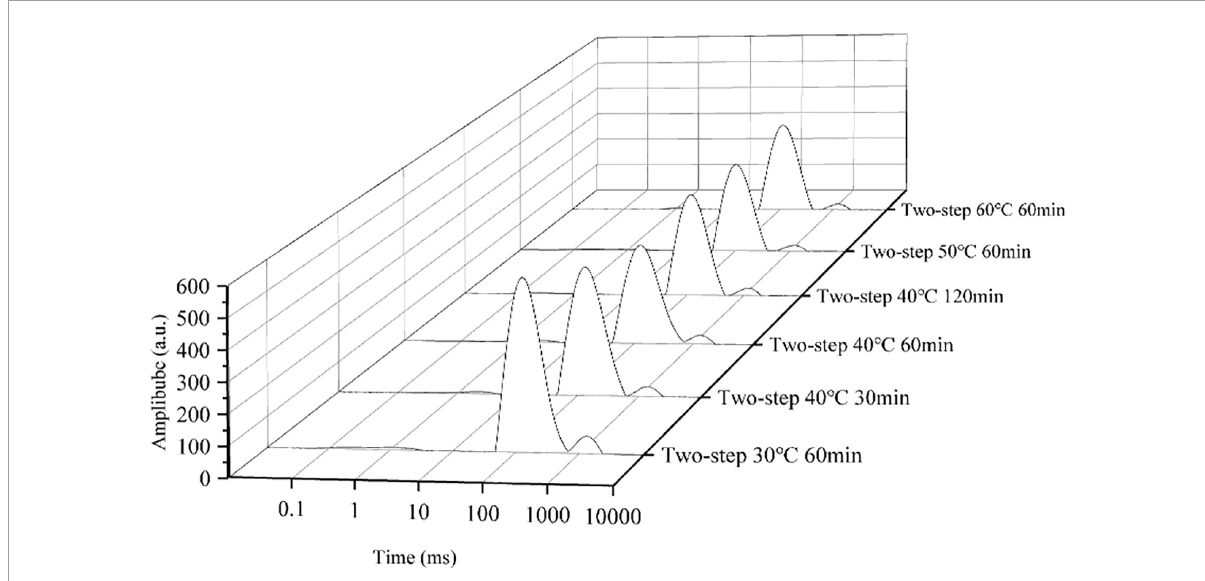
FIGURE8 The distributions of T 2 relaxation times of surimi gels formed under different gel softening